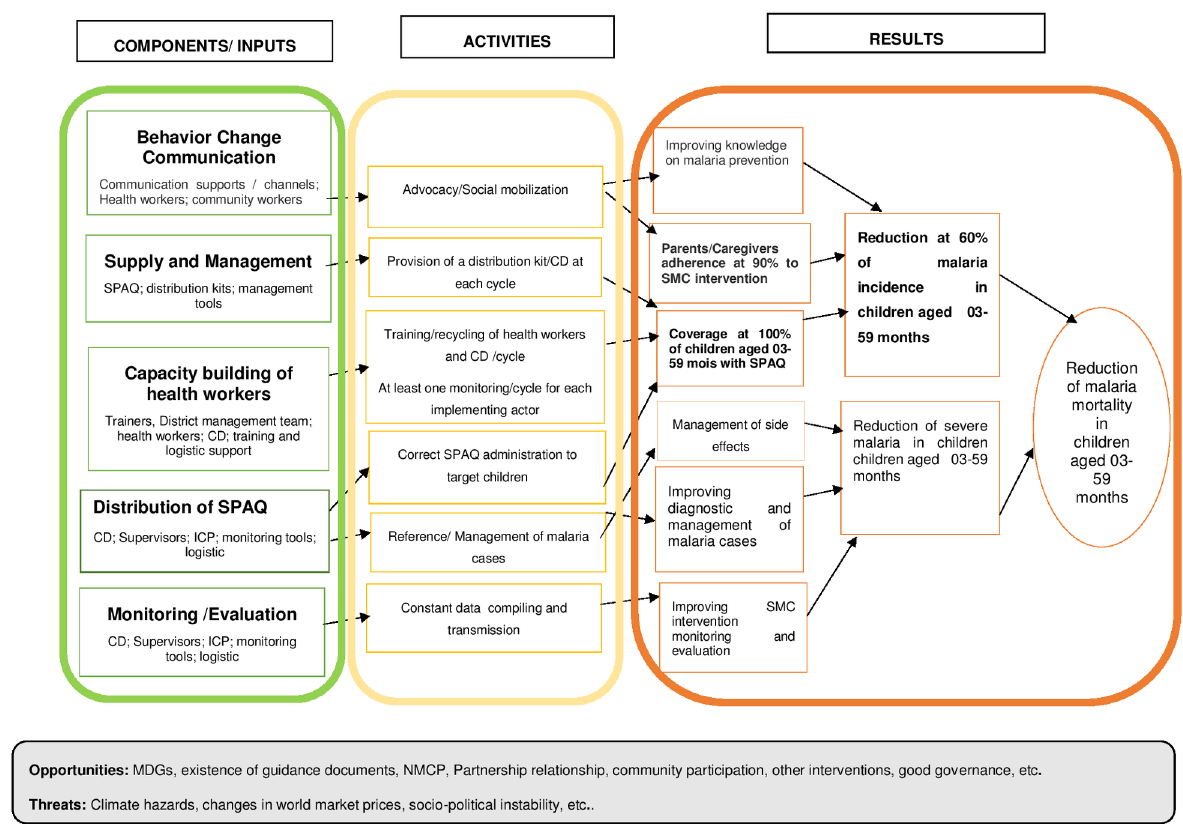
Fig 1. Logic model of the SMC